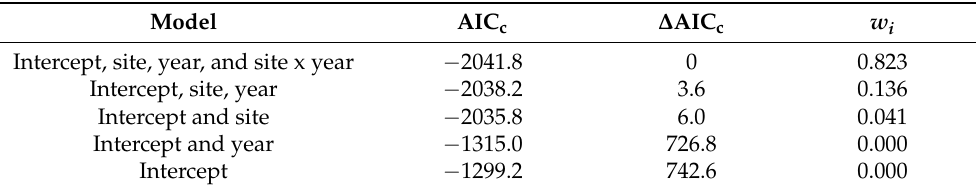
Table 2. Results of model selection using Akaike’s information criterion (AIC) for five models examining the effects of site, year, and interaction between site and year on 87 Sr/ 86 Sr ratios from northern pike in the Yampa River, Colorado,